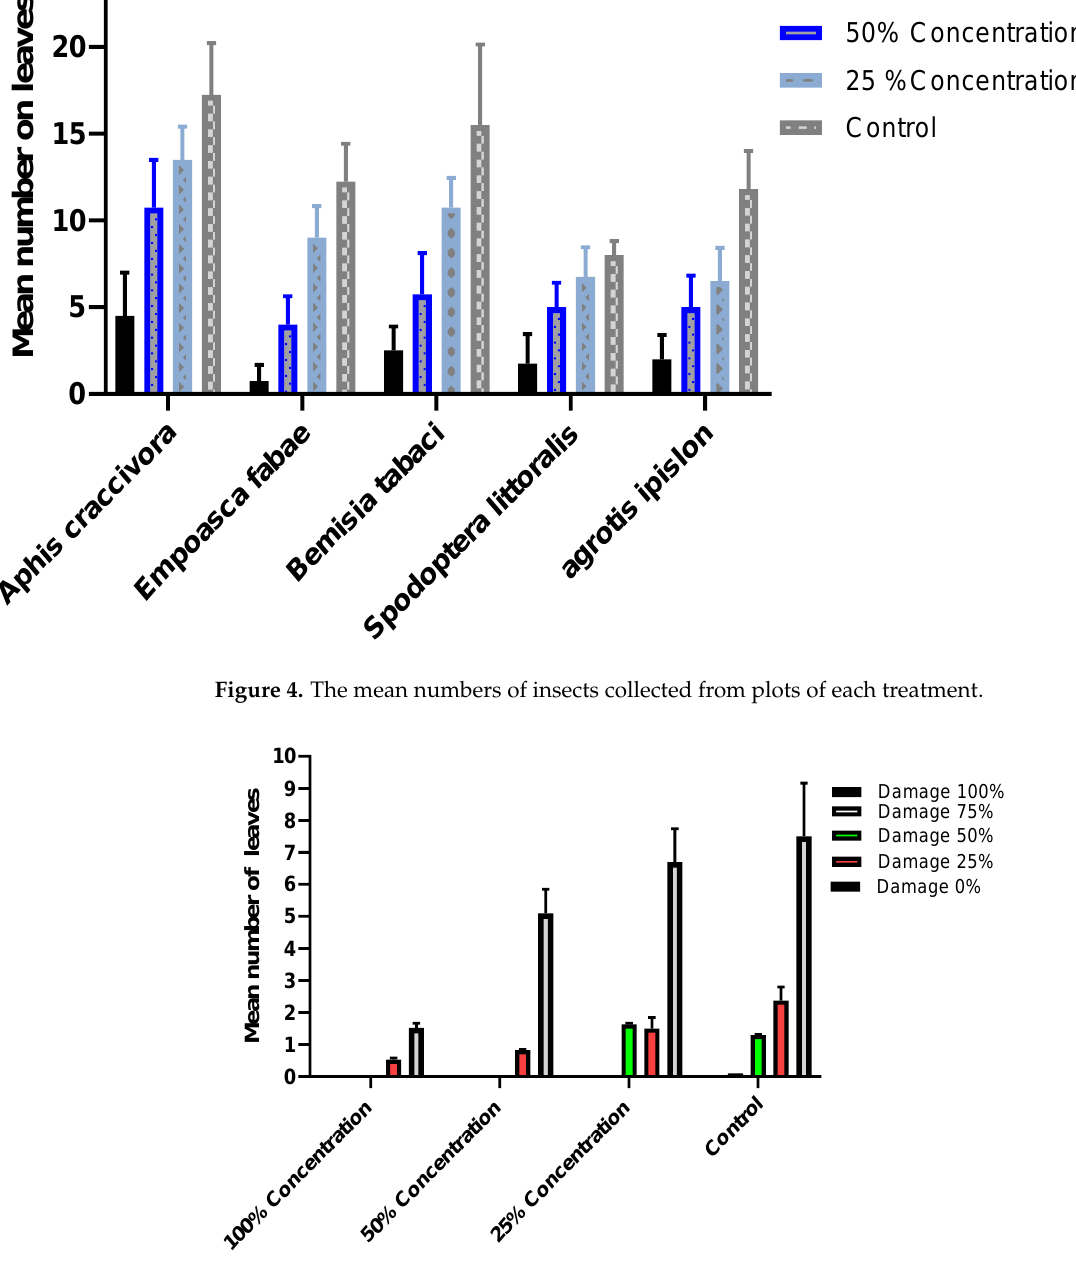
Figure 5. Effect of the SCG extract on the mean number of leaves damaged by chewing insects.